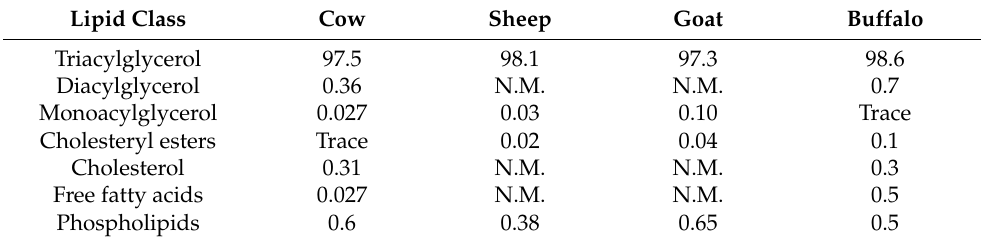
Table 2. Milk fat content for different species. Lipid